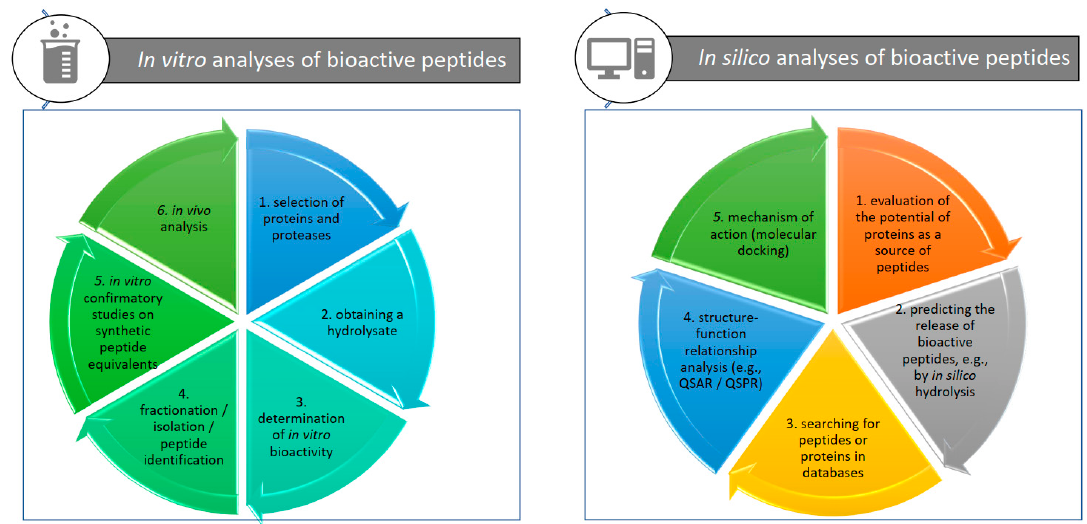
Figure 3. Tools used to identify and validate bioactive peptides from food (based on